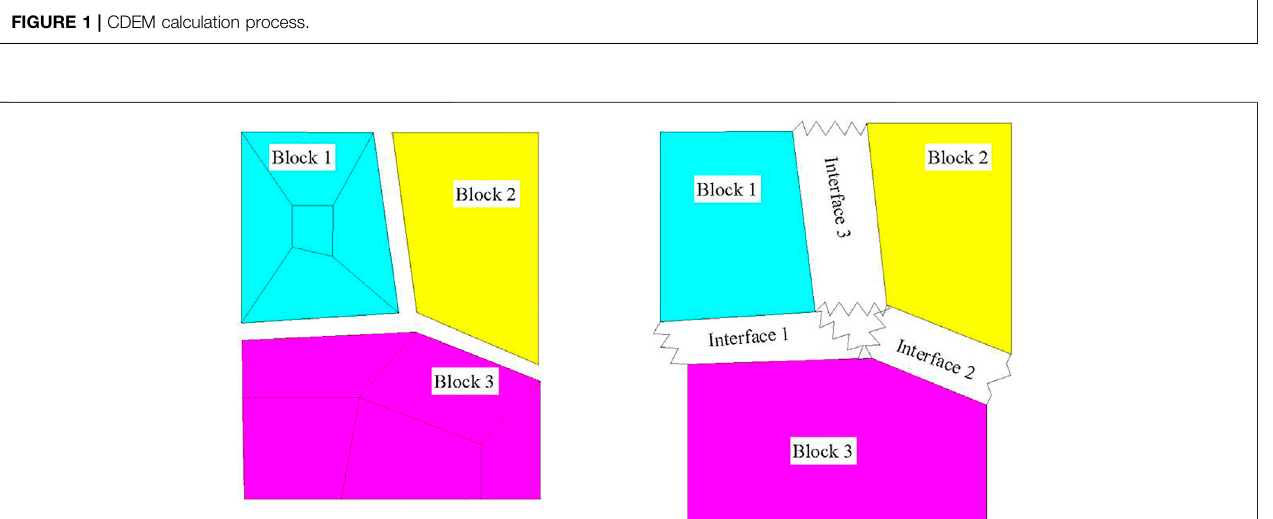
FIGURE 2 | Blocks and interfaces in CDEM.